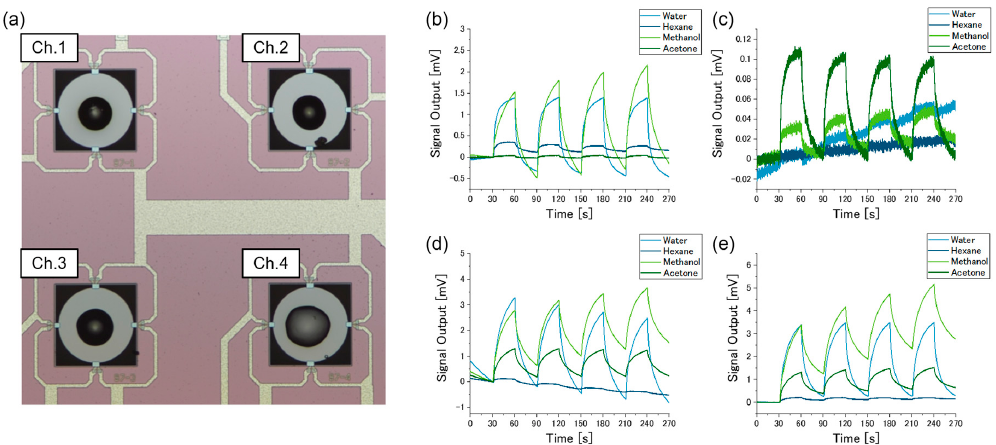
Figure 3. ( a ) Microscope image of the Membrane-type Surface stress Sensors (MSS) chip. Poly(4-vinylphenol), polyepichlorohydrin, poly(styrene-co-allyl alcohol), and poly(methyl methacrylate) were coated on Ch.1, Ch.2, Ch.3, and Ch.4, respectively. Results of the gas-sensing measurements for ( b ) Ch.1, ( c ) Ch.2, ( d ) Ch.3, and ( e ) Ch.4.